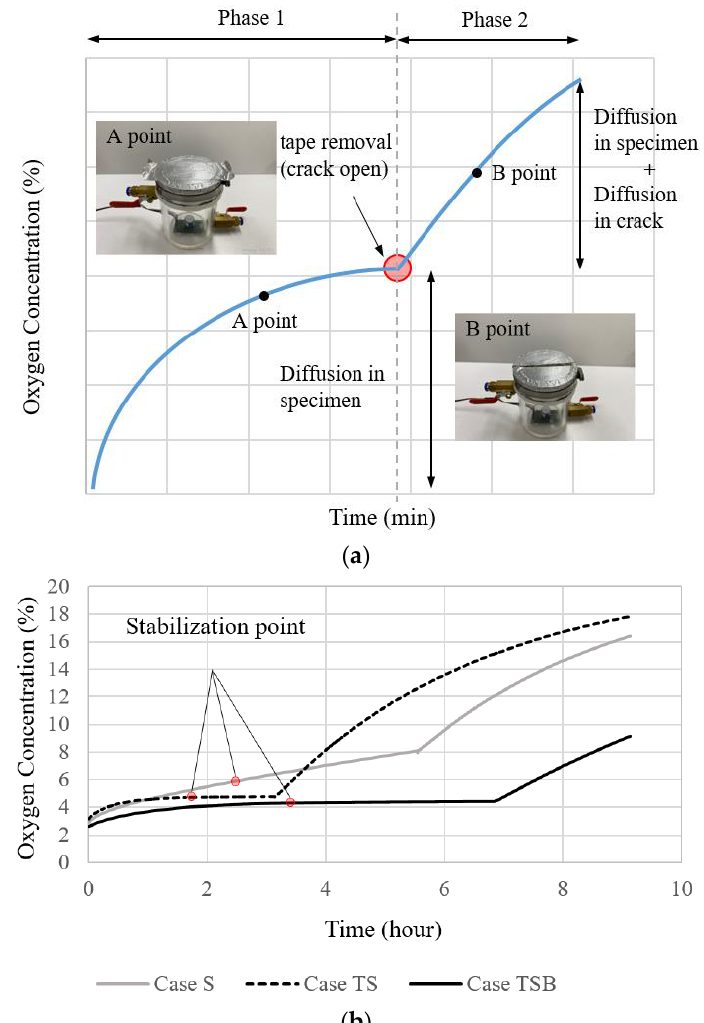
Figure 2. Concentration change in the experimental apparatus [18]: ( a ) overview of concentration changes in the test device with a crack closed or open, and ( b ) time to reach steady state in relation to the boundary condition of the specimen without pre-stabilization process.